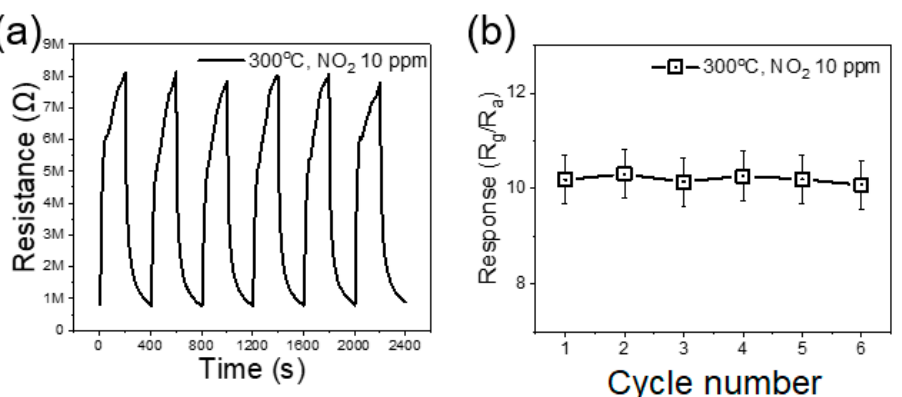
Figure 13 . Repeatability of optimized gas sensor ( a ) exposure to six sequential NO 2 (10 ppm) cycles. ( b ) Corresponding response versus cycle number.